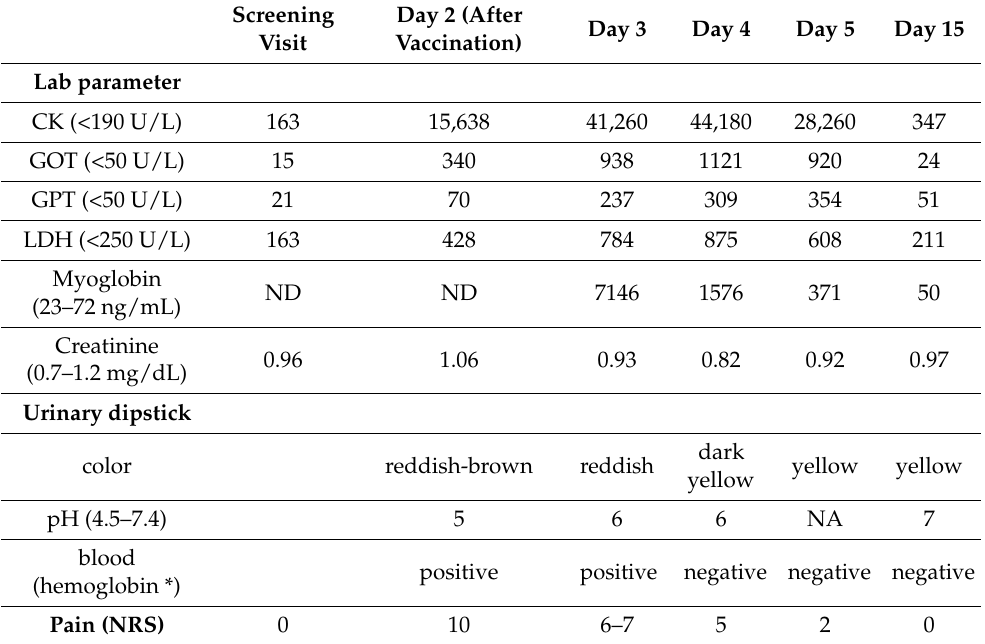
Table 1. Timeline of clinical and laboratory findings.